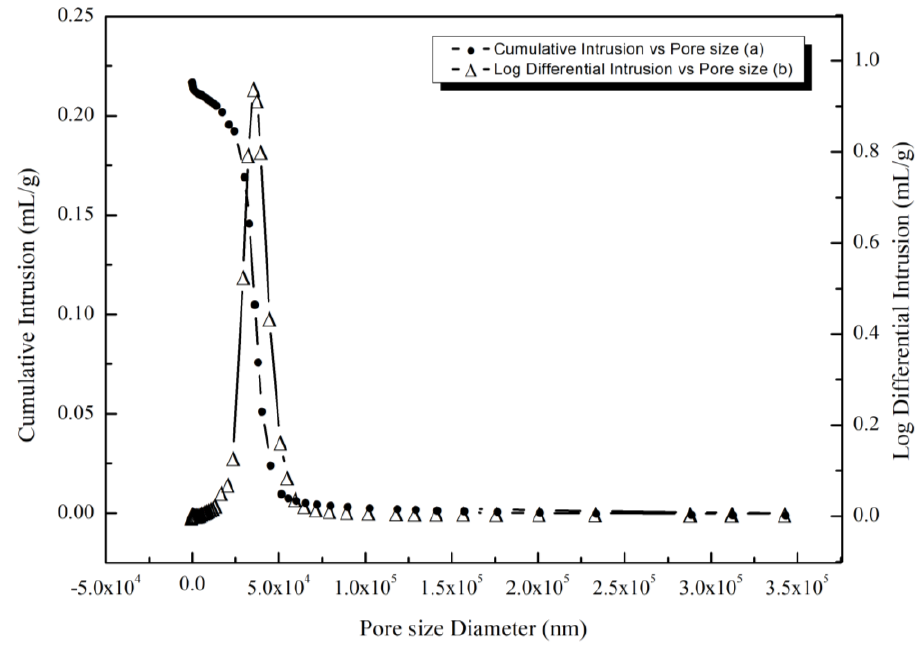
Figure 5. Pore size distribution integral and differential curves of the sample.